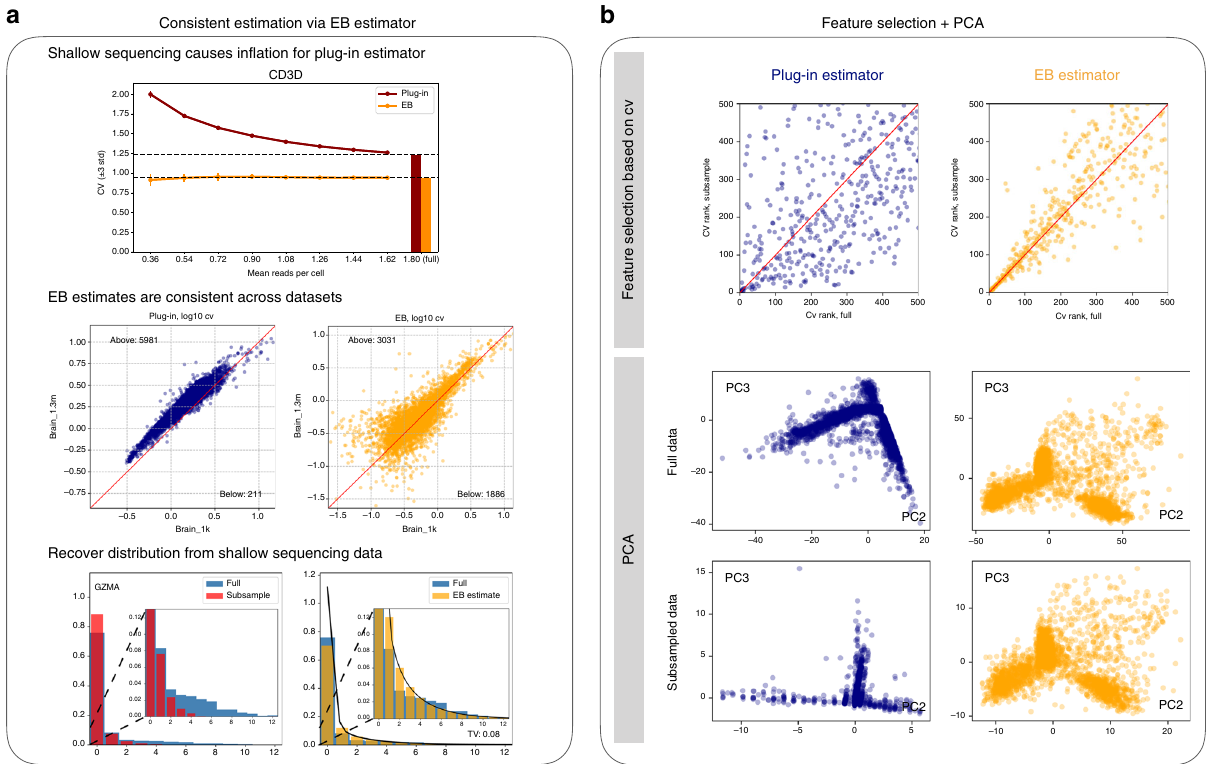
Fig. 3 EB estimates are consistent between deep and shallow datasets. a Top: for estimating the coef fi cient of variation (CV), the plug-in estimates become more in fl ated as the sequencing depth becomes shallower (from right to left along the x axis), whereas the EB estimates are consistent. 3-std con fi dence intervals are provided for this panel. Middle: both brain_1k and brain_1.3m are from the mouse brain, and hence each gene should have a similar CV value between the two datasets. This is indeed the case for the EB estimator (right), which is adaptive to different sequencing depths. However, as brain_1k is twice deeper than brain_1.3m, the plug-in estimates are biased that most points are above the 45-degree line (red). Bottom: distribution recovery for the gene GZMA from a dataset that is subsampled to be fi ve times shallower (left). The EB estimator provides a reasonable estimation for both the zero proportion and the tail shape, resulting in a small total variation error (right). b Feature selection and PCA. The task is to fi rst select features (genes) based on CV, and then perform PCA on the selected features. The results on the full data (pbmc_4k) and a subsampled (three times shallower) are compared. EB estimates are more consistent between the full data and the subsampled data for both the CV ranks (top) and the PCA plots ð κ Þ ¼ (cid:2) (cid:3) ● The inactive probability of a gene g with the de fi nition p 0 ; g E ½ exp (cid:6) κ X (cid:3) . It also has the interpretation of the proportion of zero- cg UMI cells for gene g when the cell population is sequenced κ = n reads times deeper. As special cases, κ = 1 corresponds to the probability that X cg is zero, whereas κ = n reads corresponds to the proportion of cells whose observed counts Y cg are zero. The latter was also considered in a recent work 38 . ; g fi nition p ð κ Þ ¼ ● The inactive probability of a gene pair g 1 2 with the de 0 ; g 1 g 2 E ½ exp ð(cid:6) κ ð X þ X ÞÞ(cid:3) that quanti fi es the change that both genes are cg 1 cg 2 inactive. This quantity can be used to analyze the gene co-expression network 38 . 16 ). ● The marginal gene distribution P X g (also considered in a recent work Optimal sequencing budget allocation . We considered a single gene and derived the optimal budget allocation for estimating all the above quantities of its dis- tribution P X (see Supplementary Note 5 for more details). As the mean relative g